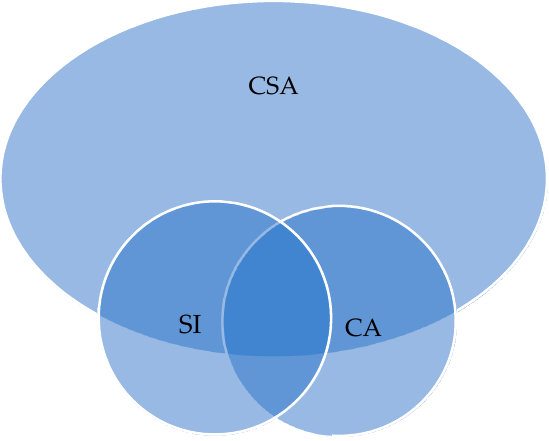
Figure 2. Relationship of the CSA, SI, and CA.